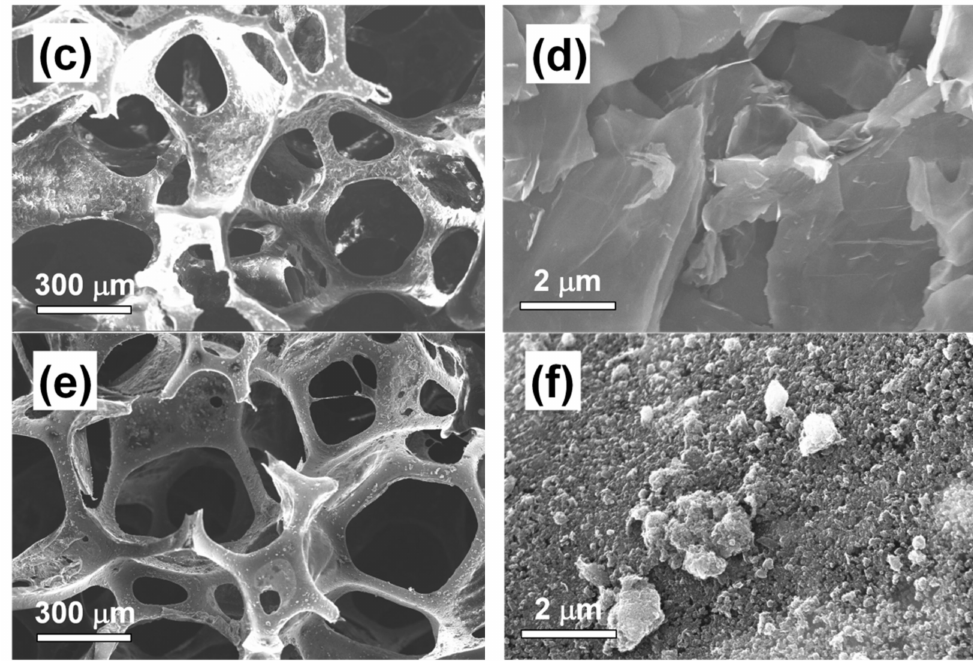
Figure 3. Scanning electron microscopy (SEM) images of PU sponge, GtPU sponge and GnPU sponge under differing levels of magnification. ( a , b ) for PU sponge, ( c , d ) for GtPU sponge, ( e , f ) for GnPU